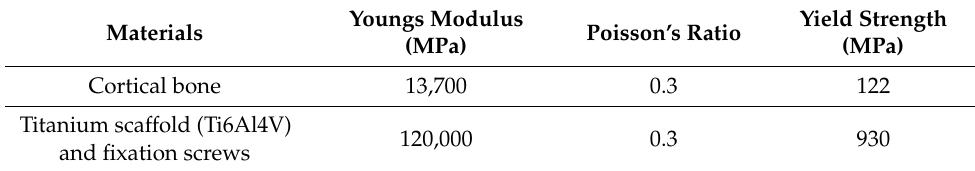
Table 2. Material properties used in the computational model [27] .